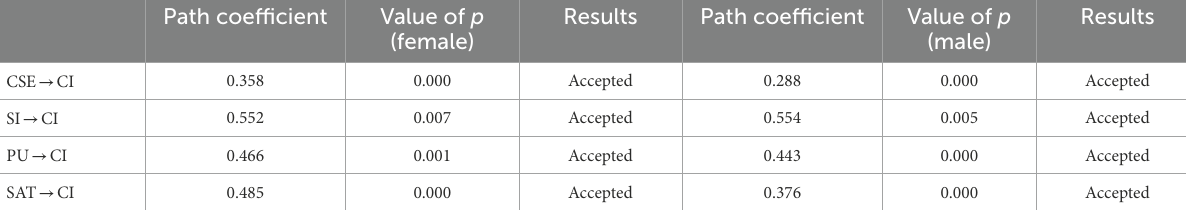
TABLE 15 Comparison